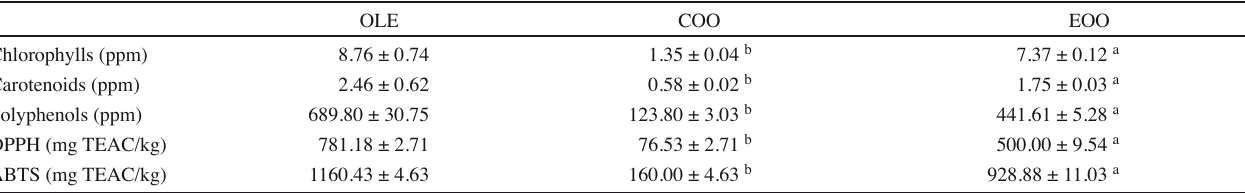
Tab. 2: Pigments, polyphenols, and antioxidant activity of oleaster leaves and studied olive oils extracts.